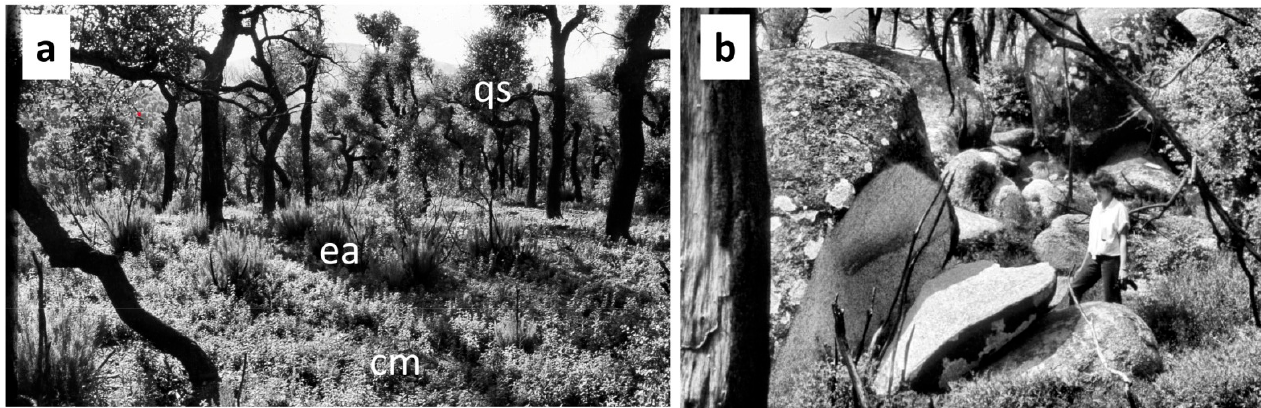
Figure 1. The studied cork oak forest the first spring after the 1986 fire. ( a ) The cork oak stand and the beginning of the regeneration of the understory the first spring after fire (qs: Quercus suber ; ea: Erica arborea clump; cm: Cistus monspeliensis seedlings). ( b ) Granite boulders peeled and broken by the heat.